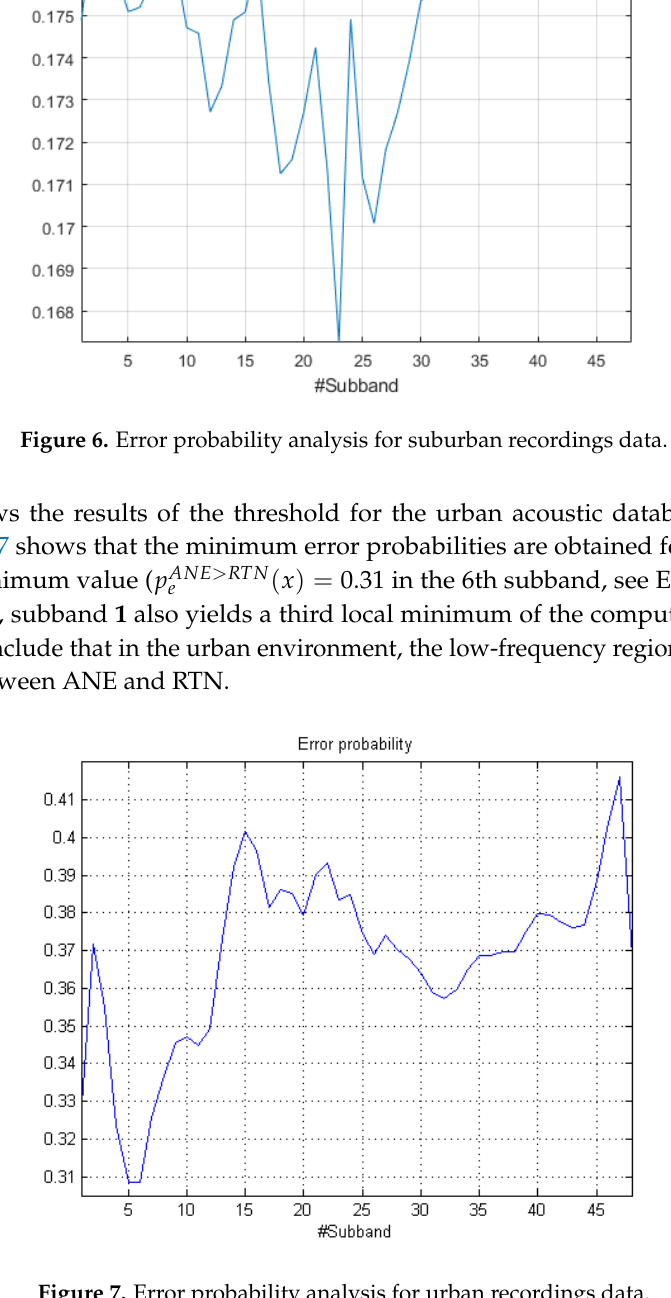
Figure 7. Error probability analysis for urban recordings